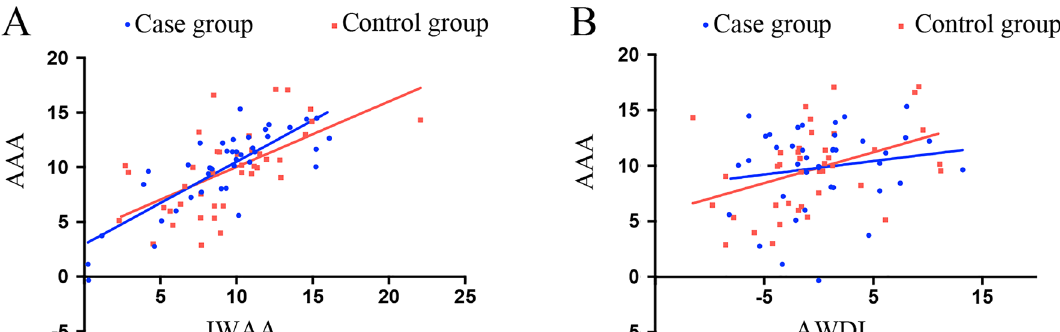
Figure 4. single factor linear regression of IWAA and awdi in patients and controls. Case group: AAA = 0.7563*IWAA + 2.941 R2 = 0.6456 AAA = 0.1215*AWDI + 9.815 R2 = 0.02686. Control group: AAA = 0.5985*IWAA + 4.042 R2 = 0.3703 AAA = 0.2787*AWDI + 9.823 R2 = 0.163. Multiple linear regression equations of two groups of affected sides. Case group: AAA = 0.355*AWDI + 0.904*IWAA + 1.434 R2 = 0.842.